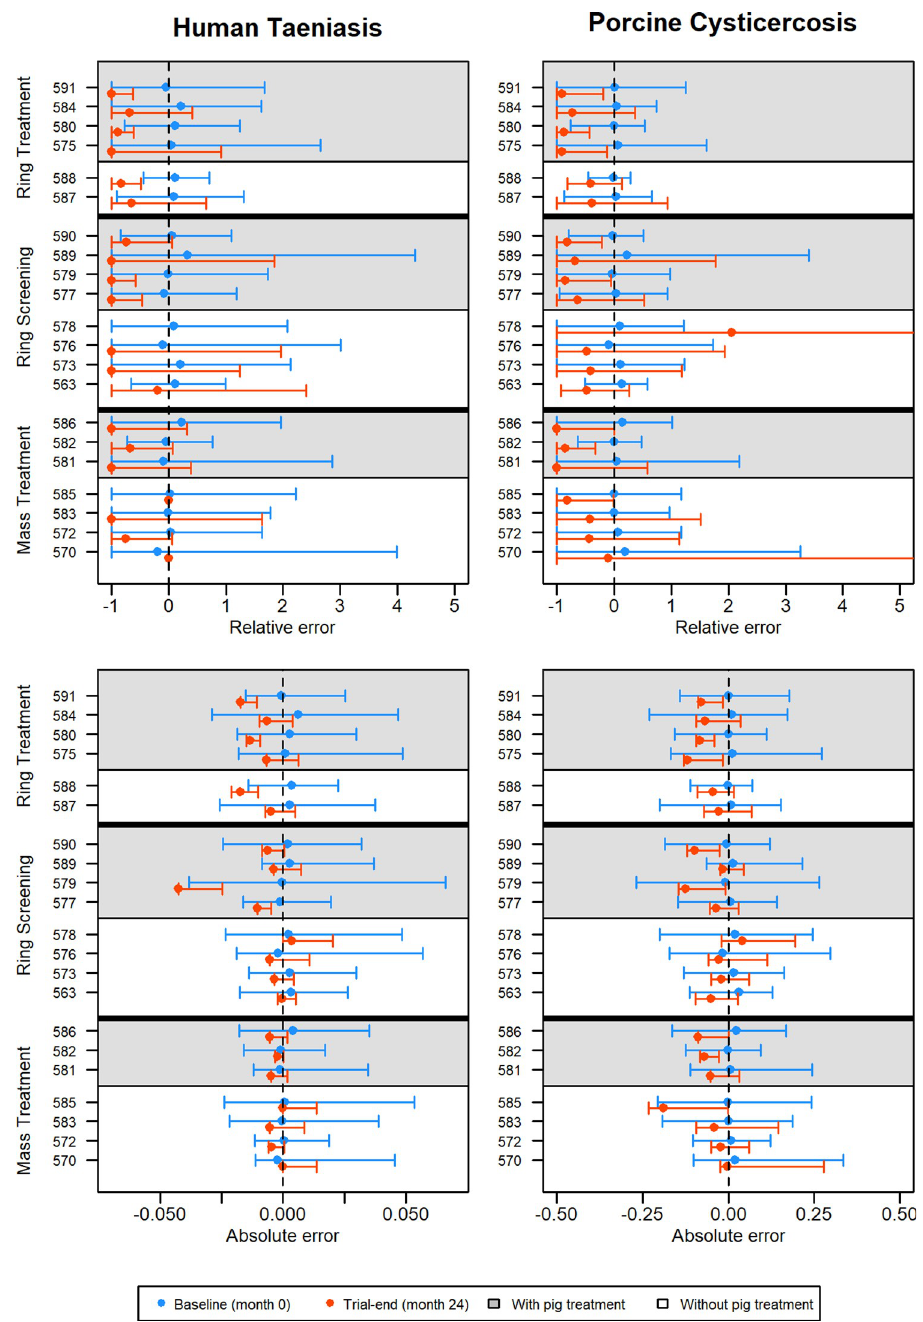
Fig 2. Relative (top) and absolute (bottom) errors during validation of CystiAgent against results from the Ring Strategy Trial for human taeniasis (left) and porcine cysticercosis (right) at baseline (month 0) and trial-end (month 24) (n = 21 villages). For ring treatment (n = 6 villages), ring screening (n = 8 villages) and mass treatment (n = 7 villages villages), interventions with (white) and without (grey) pig treatment are designated by the background color of the plot area. Three villages (570, 578, and 585) had no human taeniasis identified at trial-end and relative errors were not able to be calculated.